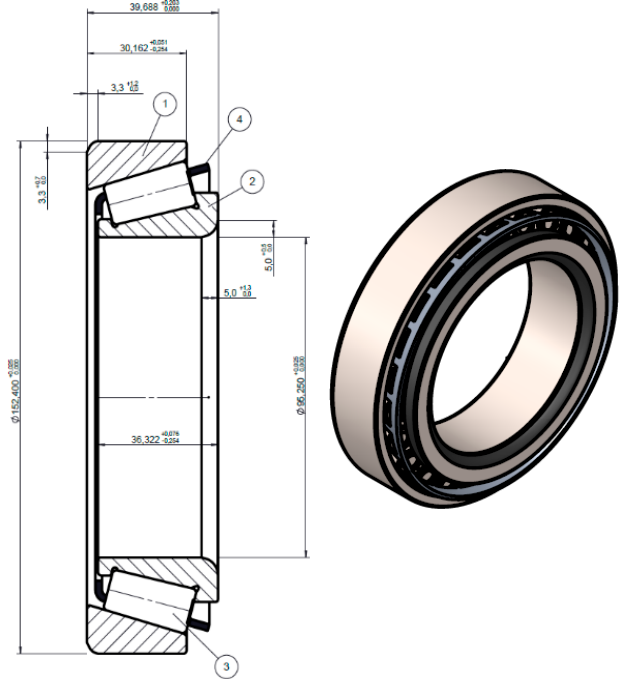
Figure 1. Tapered roller bearing 594A / 592A.